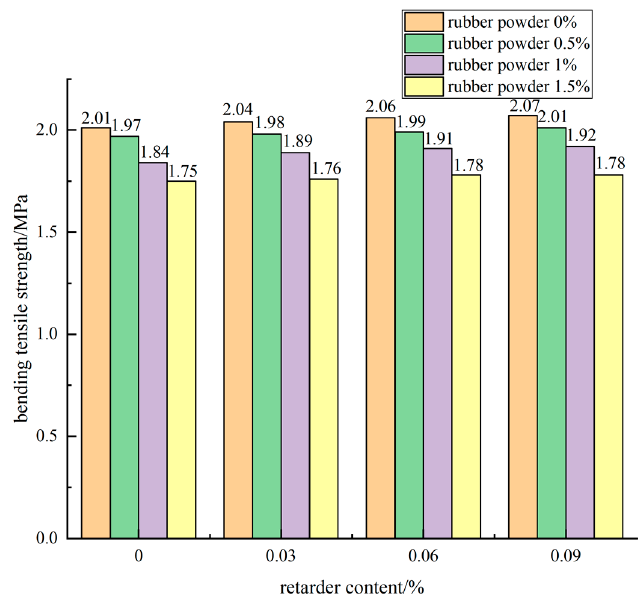
Figure 16. Effect curve of retarder content on flexural tensile strength.